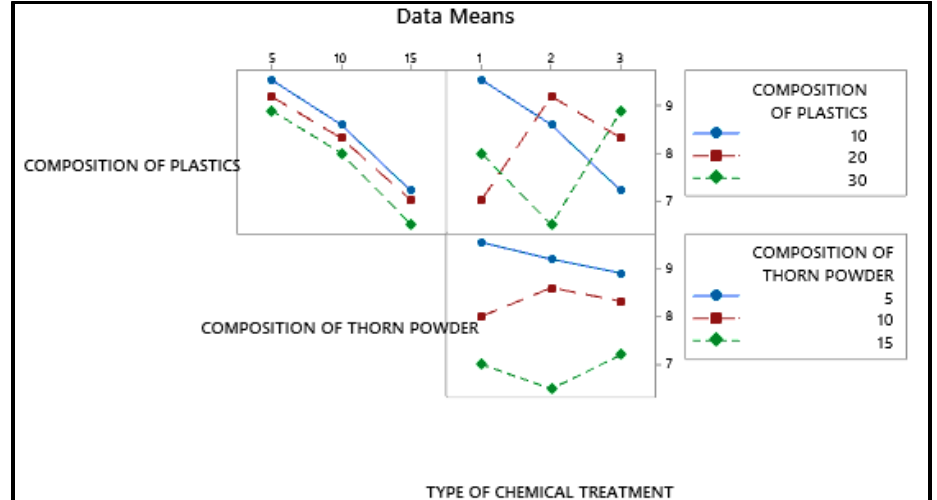
Figure 15. Interaction plot for minimum wear rate.